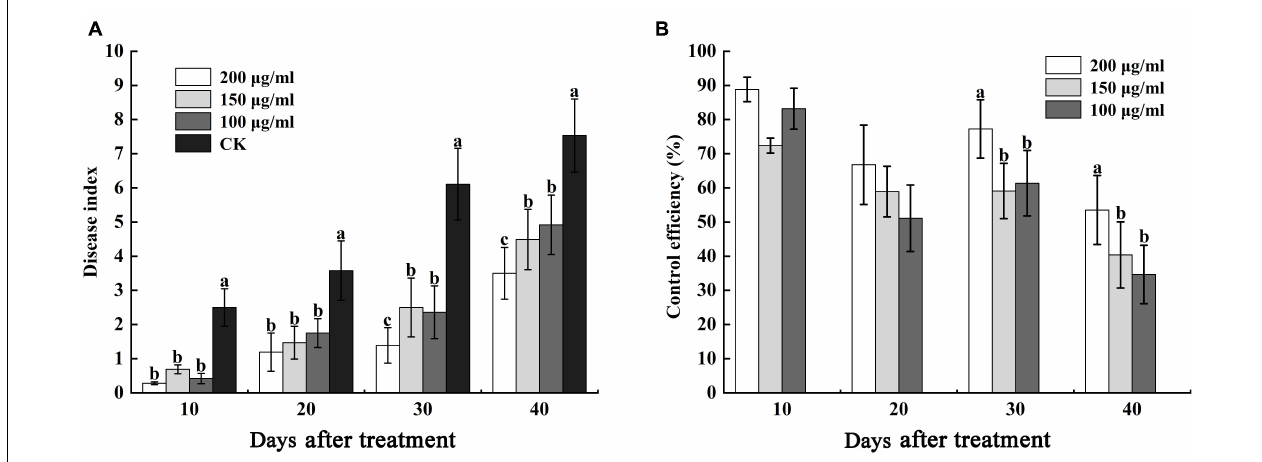
FIGURE 9 | Effects of caffeic acid at concentrations of 100–200 µ g/mL on the disease index and control efficiency of tobacco bacterial wilt. (A) The disease index of tobacco plants infected with R. solanacearum was determined. (B) The control efficiency of caffeic acid toward tobacco bacterial wilt. The lowercase letters indicate significant differences among the different treatments (Duncan’s test, p <